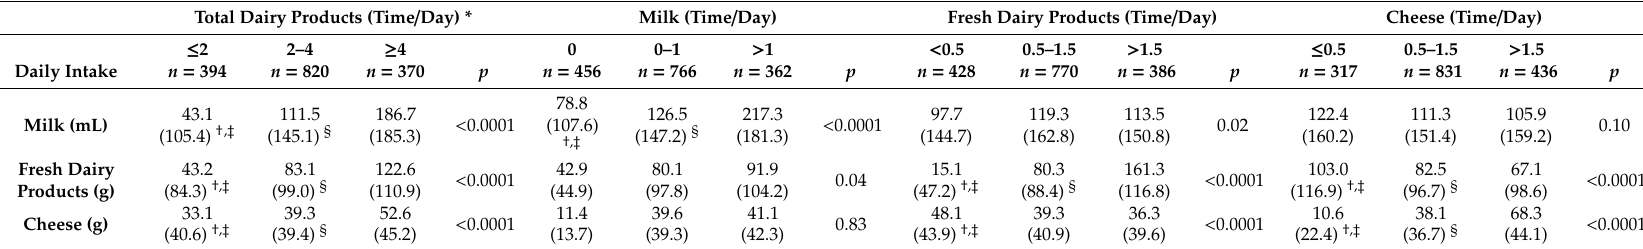
Table 4. Mean daily dairy product (and subtypes) intakes based on the weekly frequency consumption of total dairy products and dairy product subtypes among elderly community dwellers from the 3C study, Bordeaux (France), 2001–2002, n =